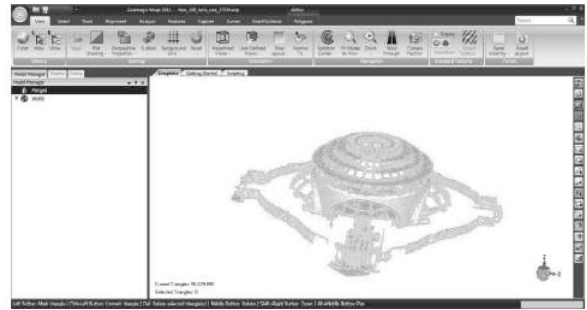
Figure 9. BIM model (Centennial Hall CMP,